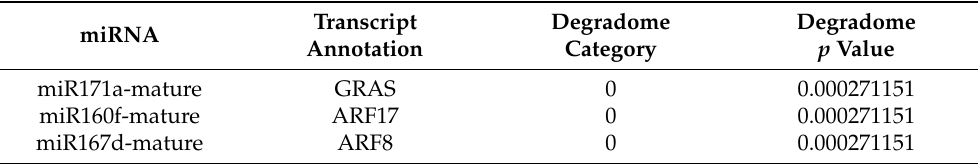
Figure 2. The DEmiRNAs found in the phloem and developing xylem of P. deltoides in this study. ( a ) Volcano plot of DEmiRNAs in the developing xylem relative to the phloem, with red and green dots representing up- and downregulated miRNAs, respectively. Detailed information on the log2 FC and Padj values of 134 miRNAs is shown in Table S5. ( b ) Clustering of the expression profiles of DEmiRNAs in the phloem and developing xylem; the expression levels were normalized by the log10 ( RPTM + 1) normalised. The DEmiRNAs were divided into different clusters based on their expression profiles. Note: Due to some miRNAs in the same miRNA family having equal y -axis and x -axis, they overlap in Figure 2a. Based on the most recent plant miRNA annotation criteria, plant miRNA identification pipelines require the mapping of sRNA sequencing reads to the reference sequence and extending the reads that could be mapped to the reference sequence upstream and downstream by 150bp each, as putative miRNA precursors. In this process, there are a number of reads that may be mapped to multiple positions that share the same sequence, belong to the same miRNA family, perform similar functions, and are distinguished by appending a, b, and c to the nomenclature, respectively. Although they share the same sequence, in reality they are still different genes and, in theory, should be expressed differently, but at this stage, sRNA sequencing does not distinguish the extent to which each gene locus contributes to the overall expression, so the overall expression is used, leading to this phenomenon. Table 2. Target genes of miRNAs identified in the phloem and developing xylem of P. deltoides by degradome